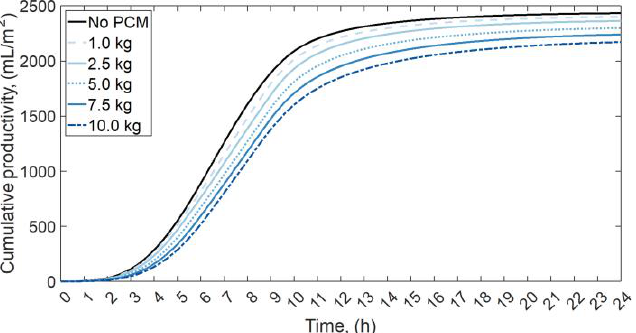
Figure 13. The cumulative productivity of the SS with different masses of PCM — Case 1.